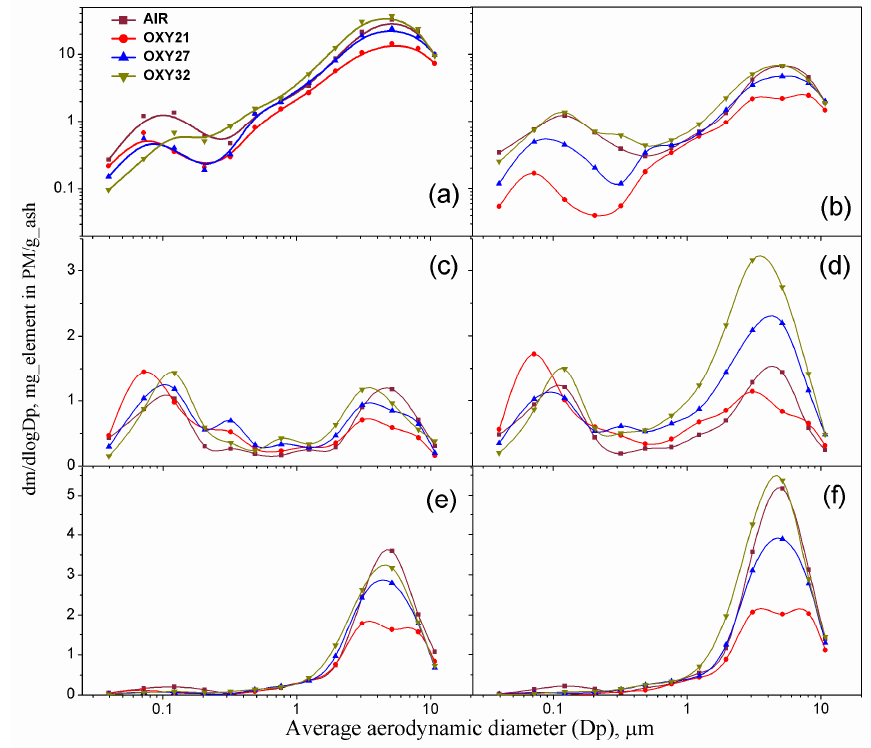
Figure 6. Elemental PSDs of PM 10 generated from the air and oxy-fuel combustion of ZD coal. ( a ) Ca, ( b ) Mg, ( c ) Na, ( d ) S, ( e ) Si and ( f ) Al.